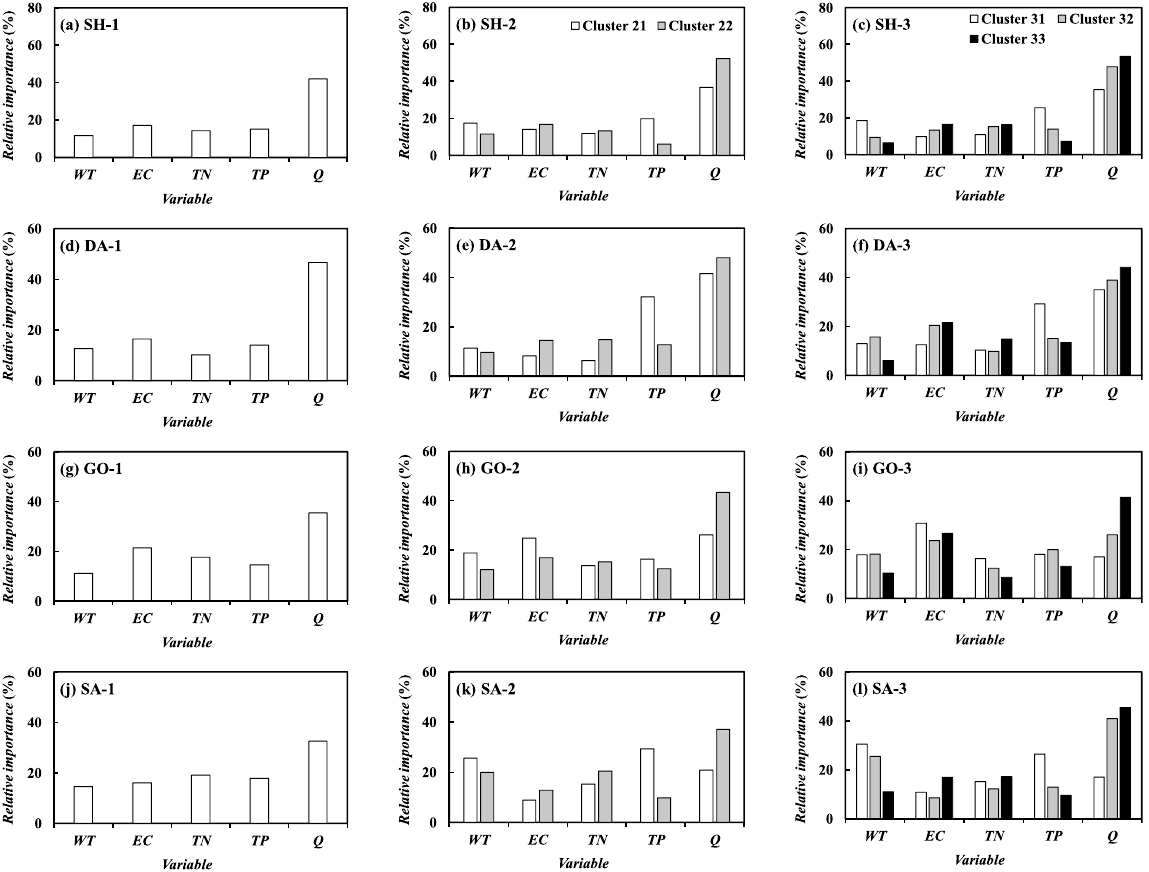
Figure 4. Relative importance of explanatory variables on predicted Chl-a belonging to different ranges of water temperature constituting each cluster in ANN